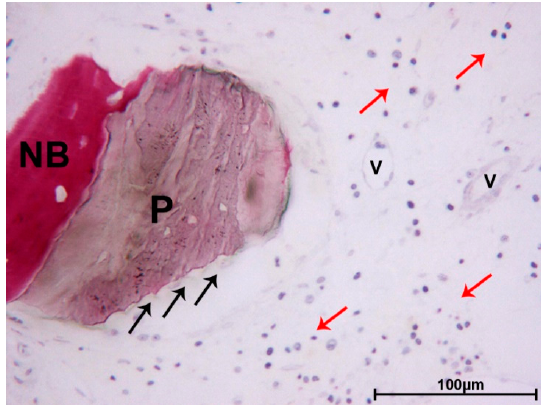
Figure 4. DEBM . Moderate inflammatory infiltrate (red arrows) and small-sized vessels (V) were observed close to a DEBM granule (P), which presented indented margins (black arrows), probably due to a resorption process. A portion of the particle was in contact with newly formed bone (NB). Toluidine blue and acid fuchsin, original magnification 200×.